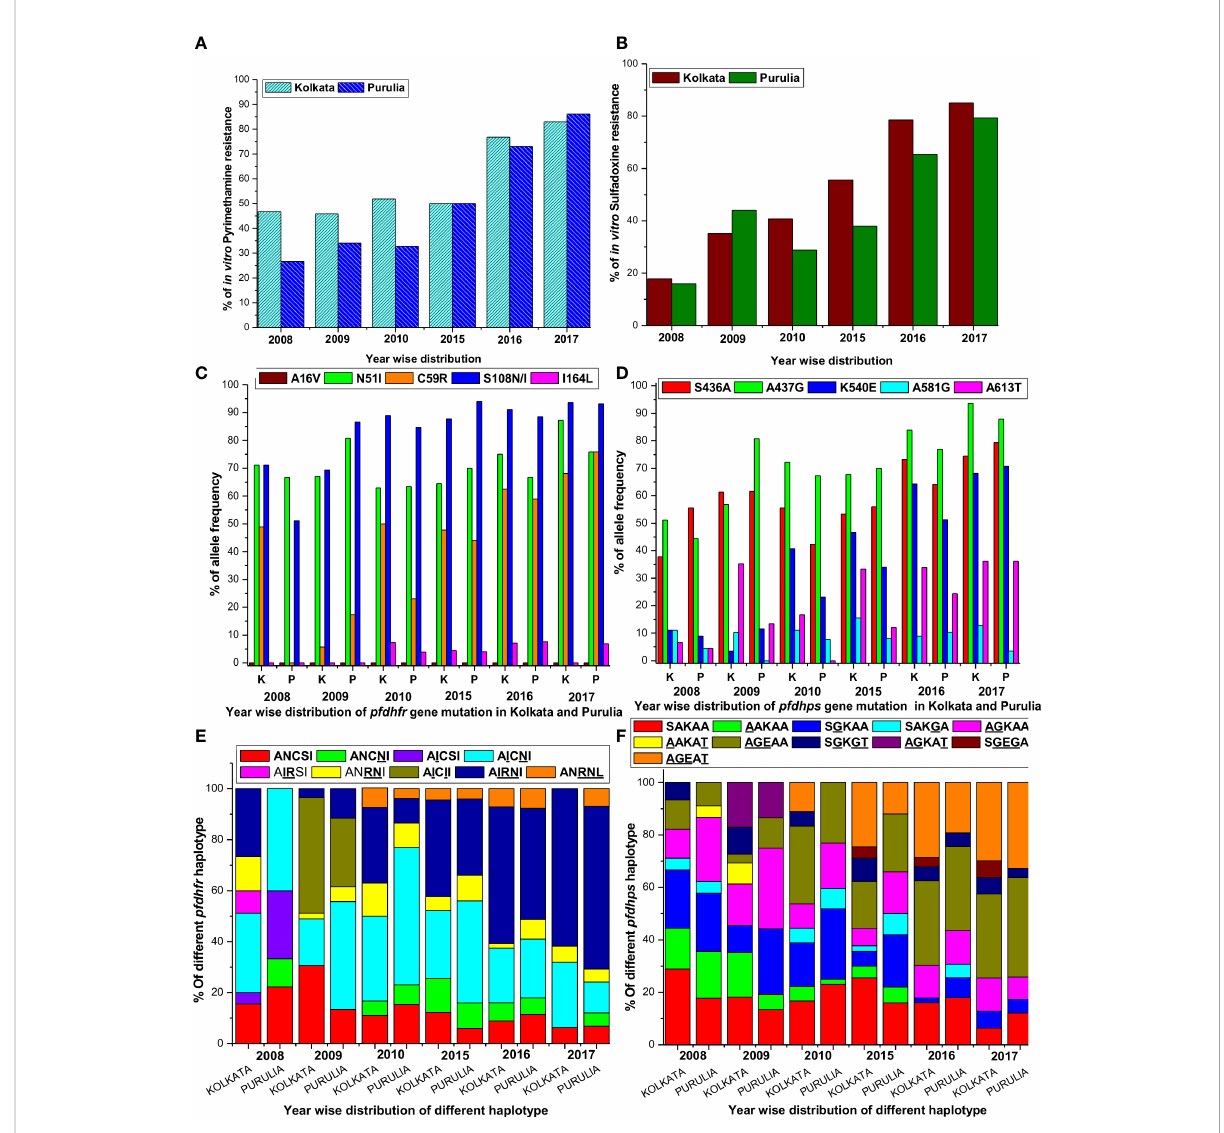
FIGURE 2 (A) Proportion of in vitro pyrimethamine resistance from 2008 to 2017 in two study sites. (B) Proportion of in vitro sulfadoxine resistance from 2008 to 2017 in two study sites. (C) Single nucleotide polymorphism of different codons of pfdhfr gene in both study sites. (D) Single nucleotide polymorphism of different codons of pfdhps gene in both study sites. (E) Alteration of different pfdhfr haplotype frequencies in different period in both the study sites. (F) Alteration of different pfdhps haplotypes in different time frame at our study